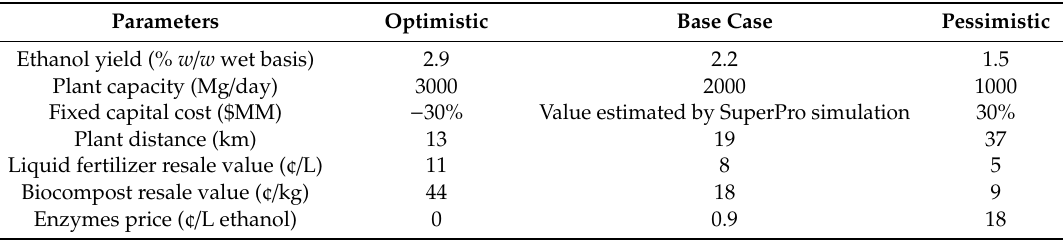
Table 3. Sensitivity analysis parameters for all